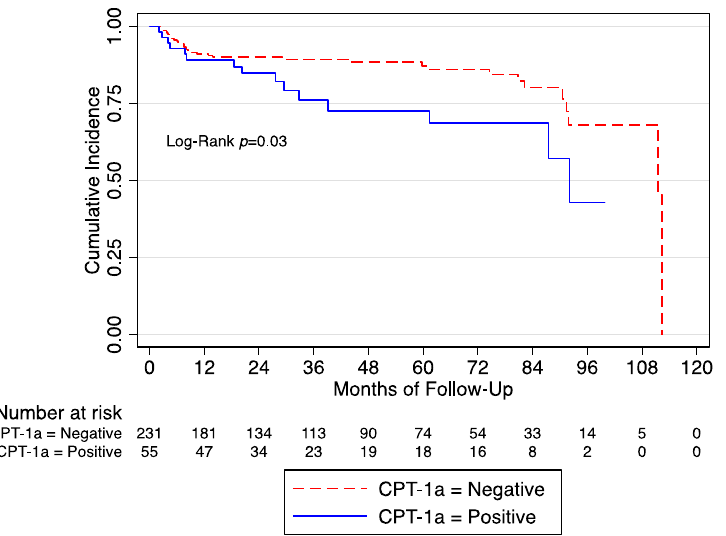
Figure 1. Biochemical recurrence free survival in the whole cohort according to the expression of CPT-1a. CPT = Anti-carnitine palmitoyl transferase CPT-1a. CPT = Anti-carnitine palmitoyl